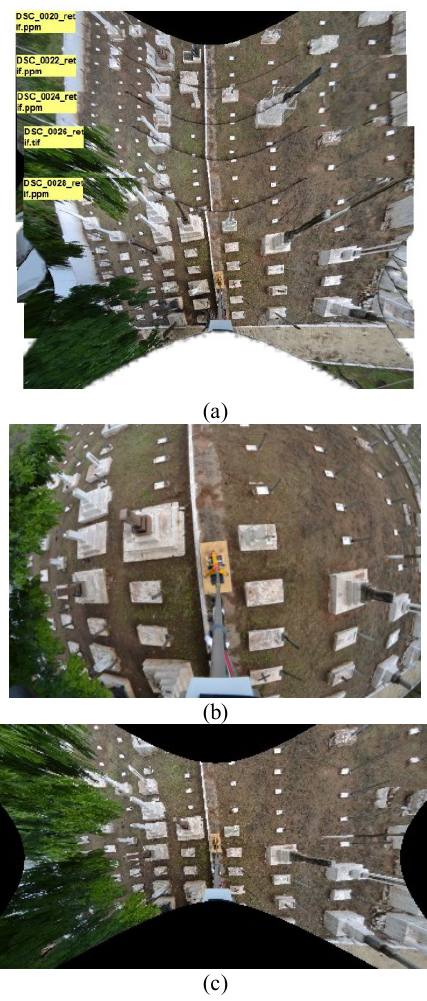
Figure 4. (a) A mosaic with the resampled images (b) Original vertical image acquired by the camera with fisheye lenses; (c) resampled image.